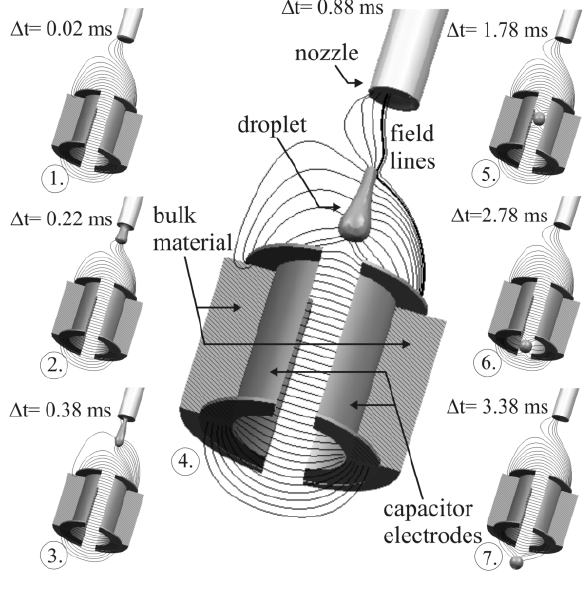
Figure 7. Simulated field distribution and droplet flight through the capacitor, including the droplet ejection